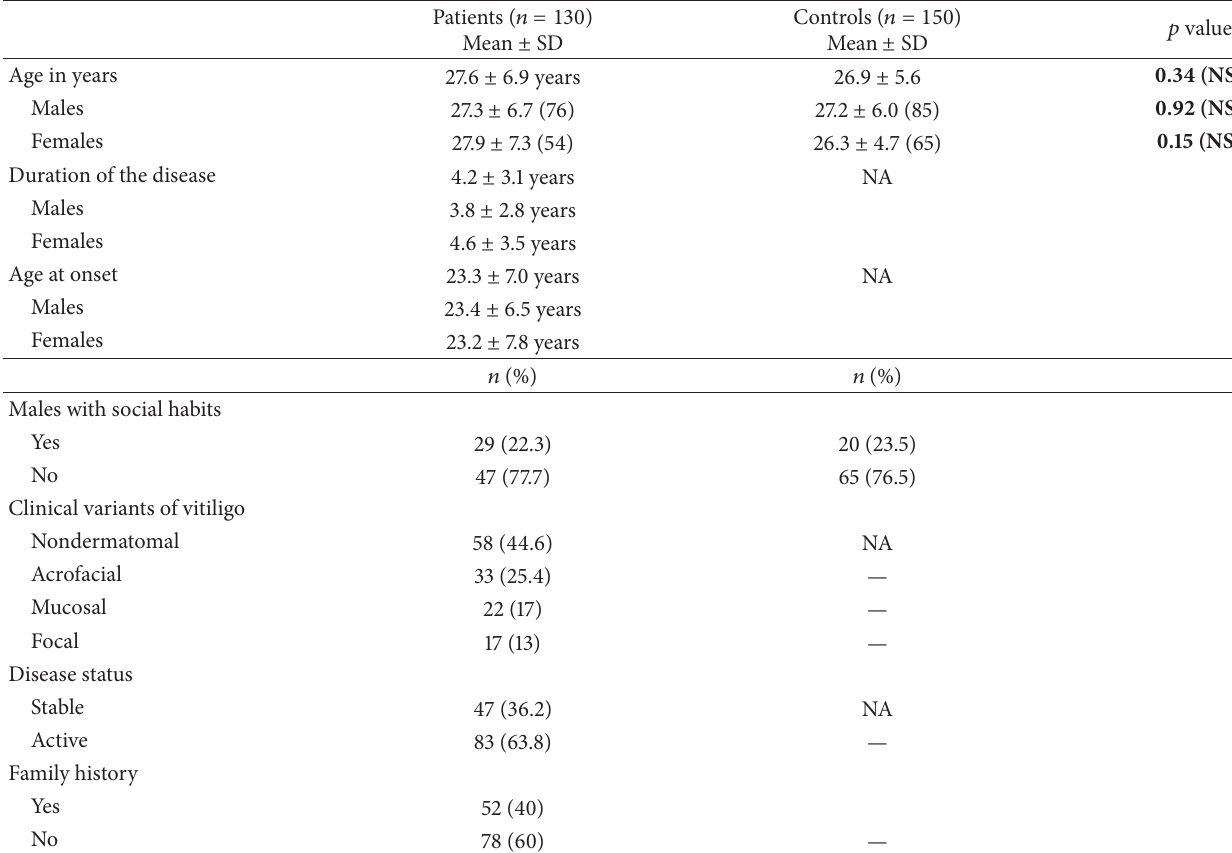
Table 1: Demographic and clinical characteristics of subjects included in the